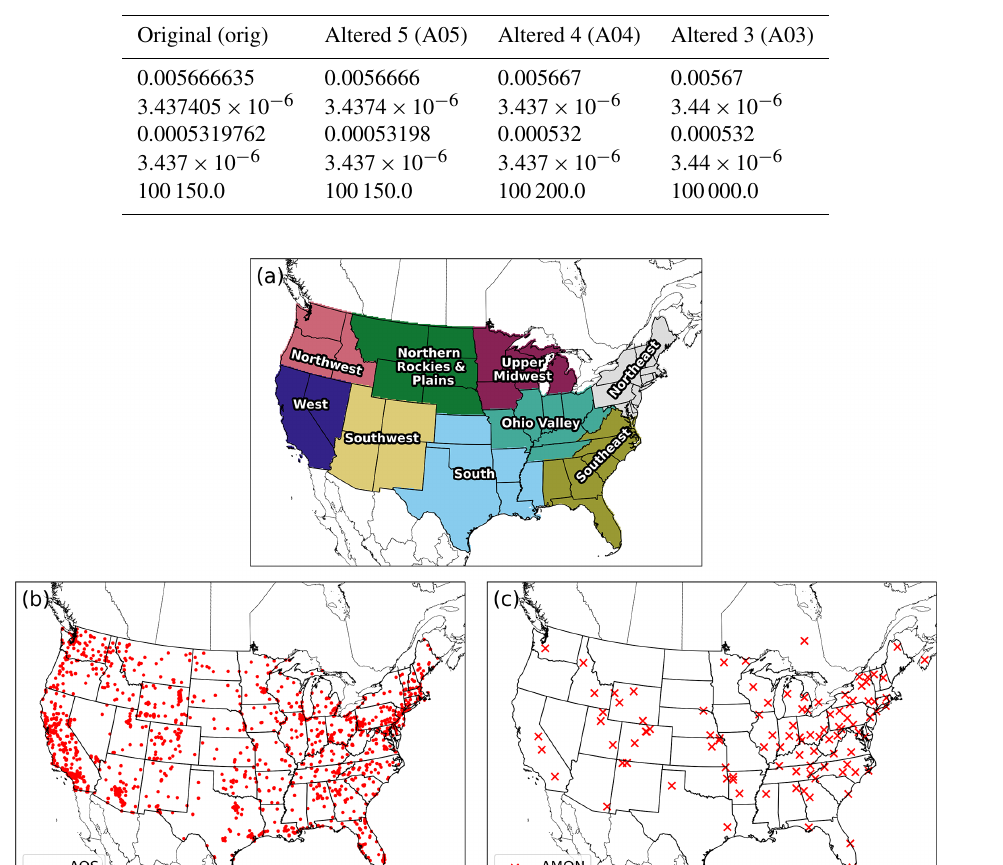
Table 1. Examples of precision-reducing transformations of floating points from their original forms (first column) to their altered precision forms (second to fourth column).